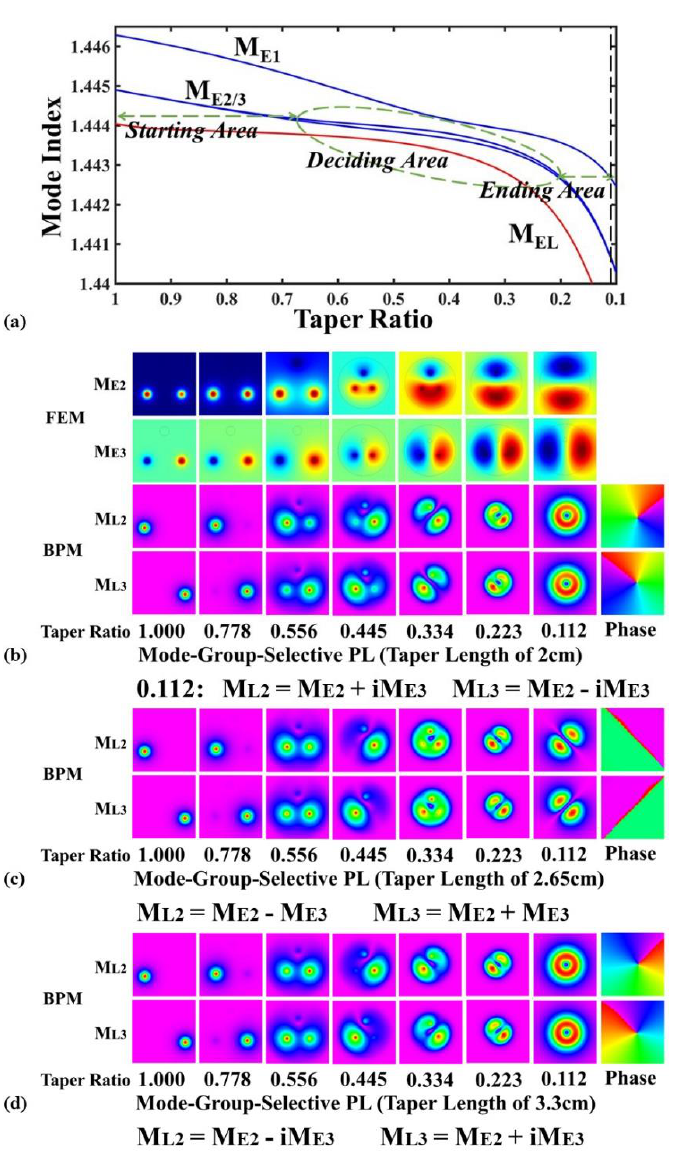
Figure 3. The FEM simulation mode indexes’ evolution along the taper of the mode-group-selective PL ( a ). The comparison of the FEM/BPM simulated mode profiles at different positions along the taper when selectively injecting light into the Fiber 2 and 3 cores of the mode-group-selective PL with the taper length of ( b ) 2, ( c ) 2.65, and ( d ) 3.3 cm.